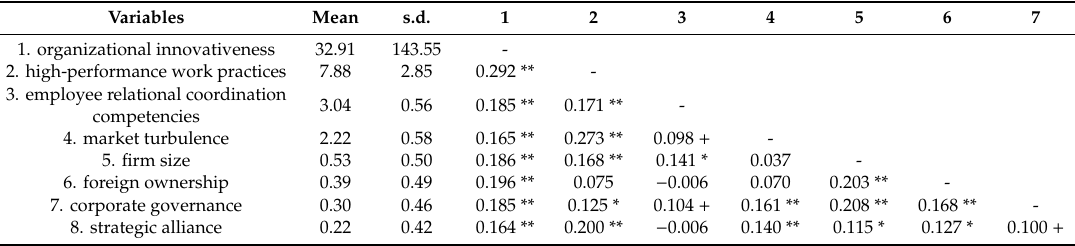
Table 2. Means, standard deviations and